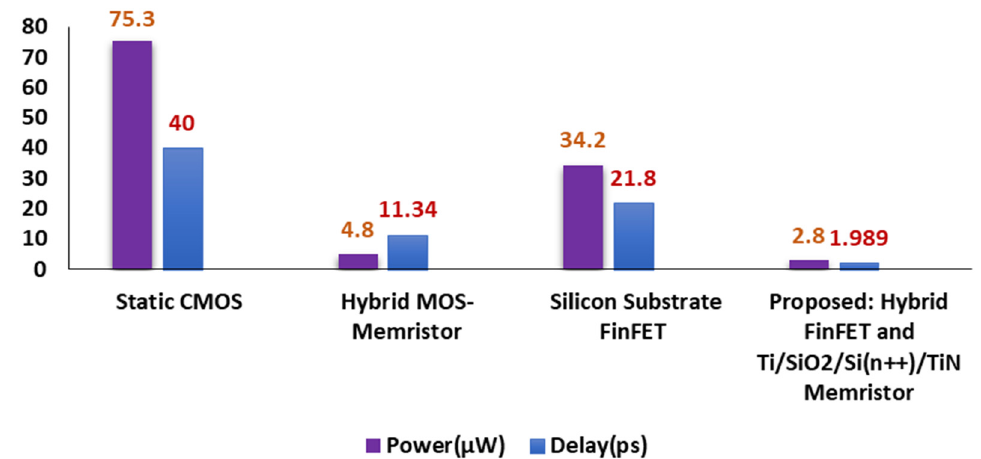
Figure 16. Power and Delay comparison of various 6T-SRAM designs with the proposed hybrid Si substrate FinFET–Ti/TiN Memristor.